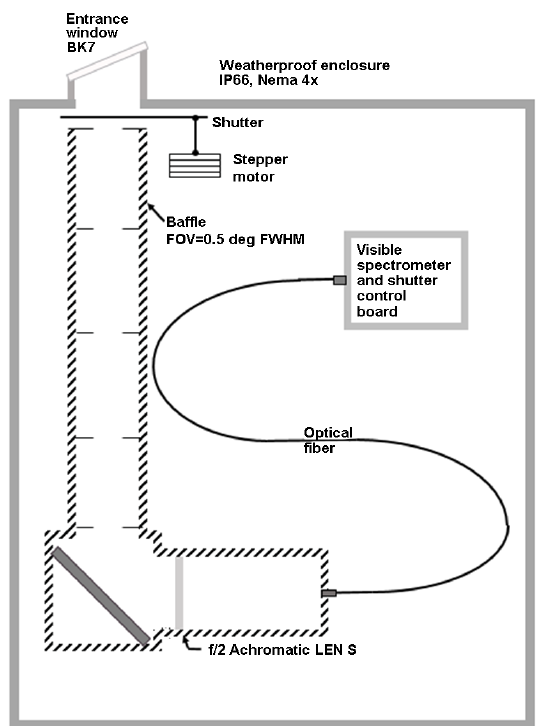
Figure 1. Simplified schematic of the TWST cloud optical depth